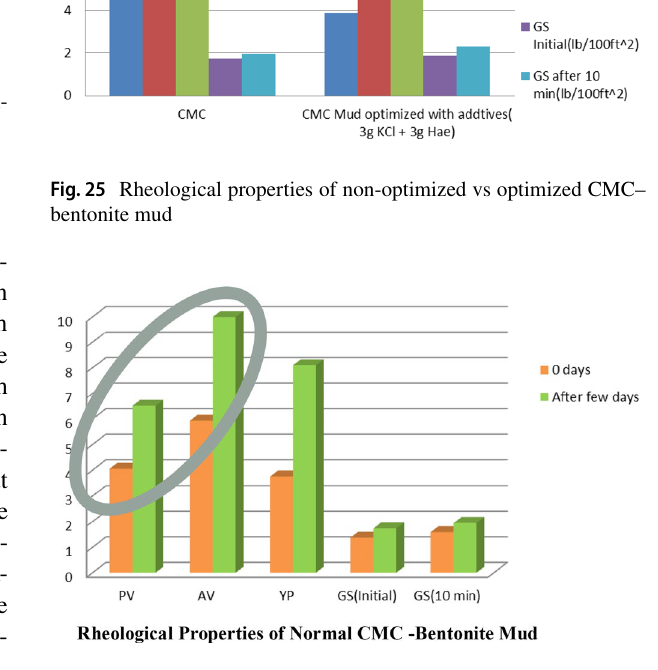
Mud sample Mud balance Marsh funnel